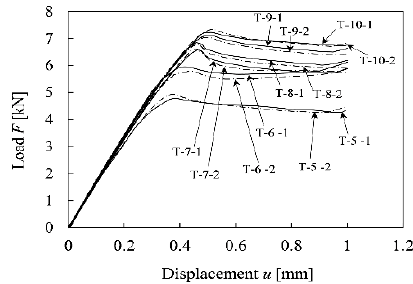
Figure 10. The load–displacement curves of connections with different prevailing torques.